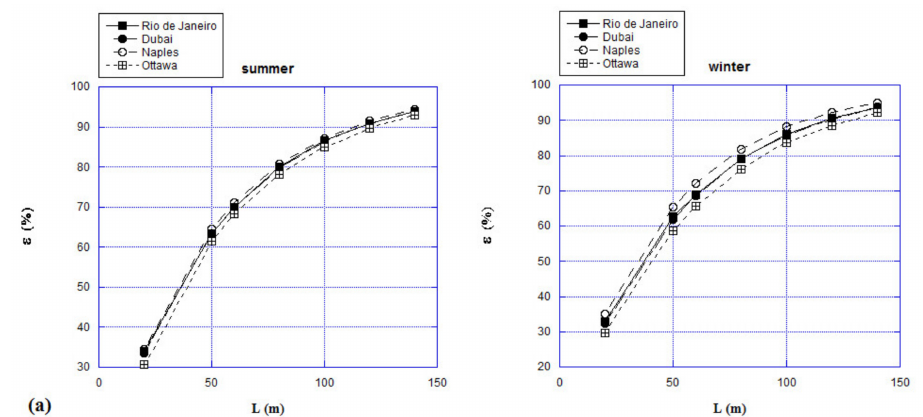
Figure 11. E ffi ciency of the GAHX, as a function of tube length for 2.5 m s − 1 as air flow velocity in: ( a ) summer and ( b ) winter